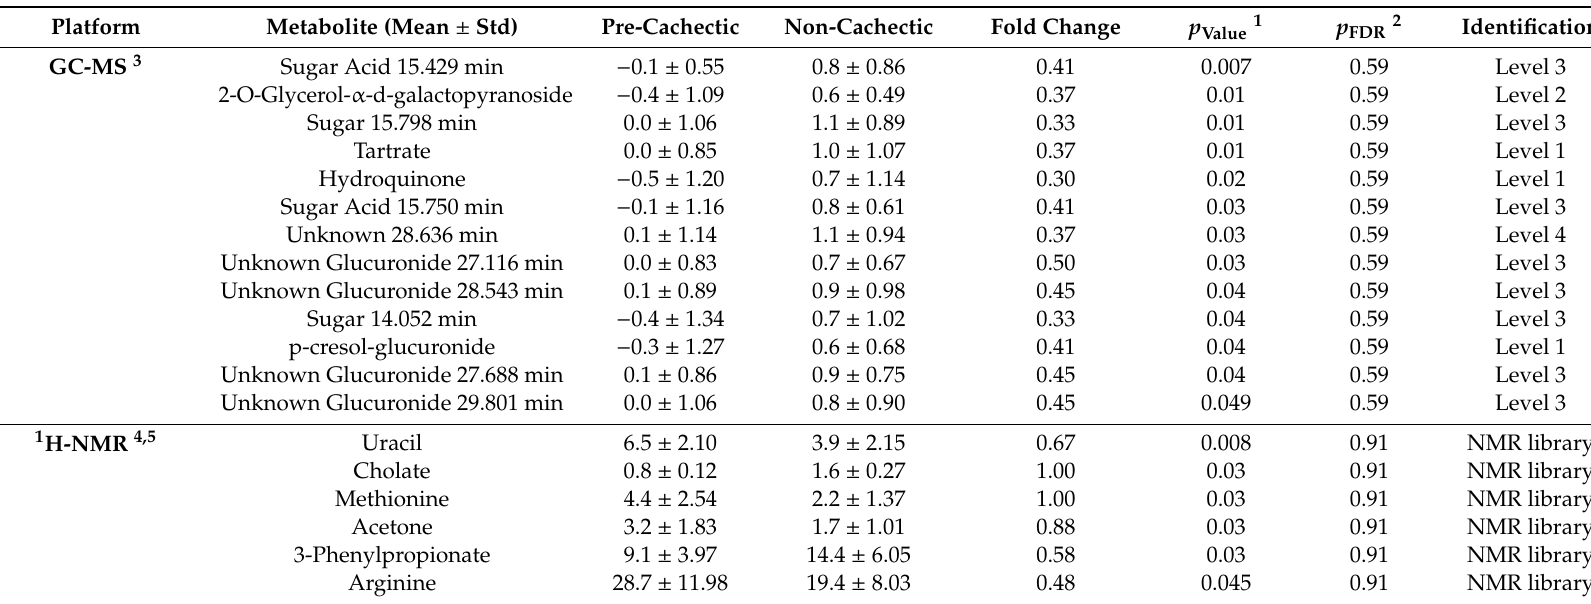
Table 6. Comparison of mean level of metabolites in pre-cachectic and non-cachectic patients. Intensities of the raw peak area of a certain ion (GC–MS) were normalized by sum, log-transformed, and auto-scaled and each spectral bin ( 1 H-NMR) was normalized to creatinine ( µ mol / mmol creatinine) and auto-scaled.